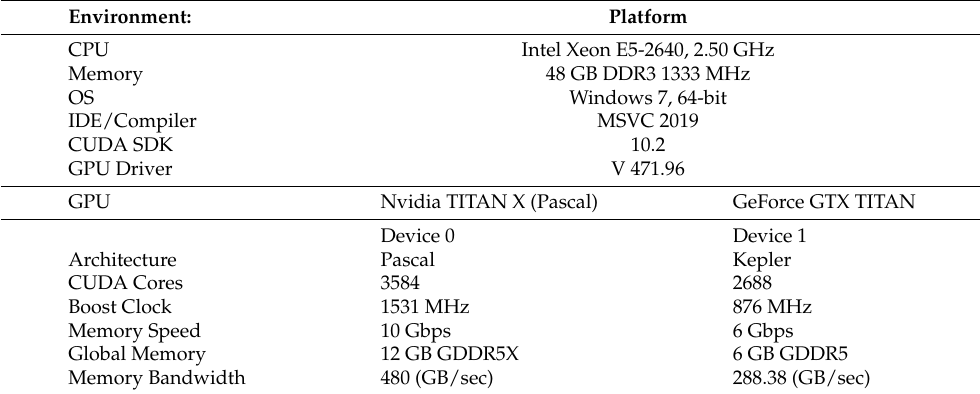
Table 1. Description of the used CPU and GPU devices.